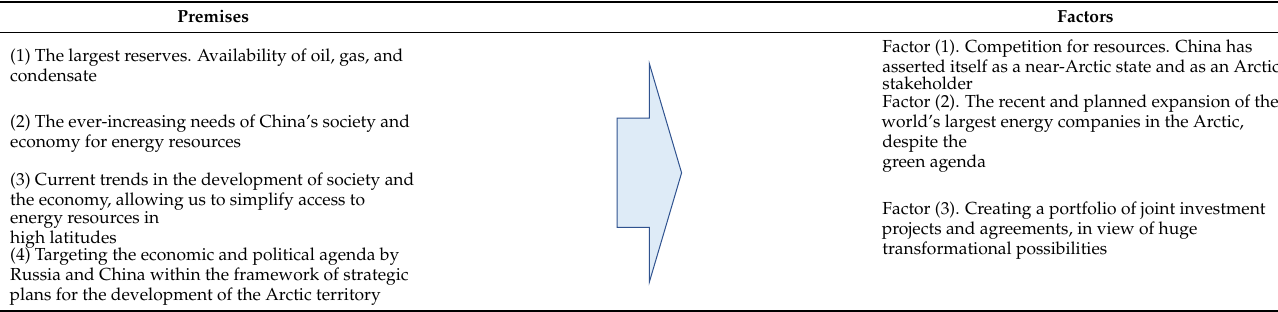
Table 8. Premises and